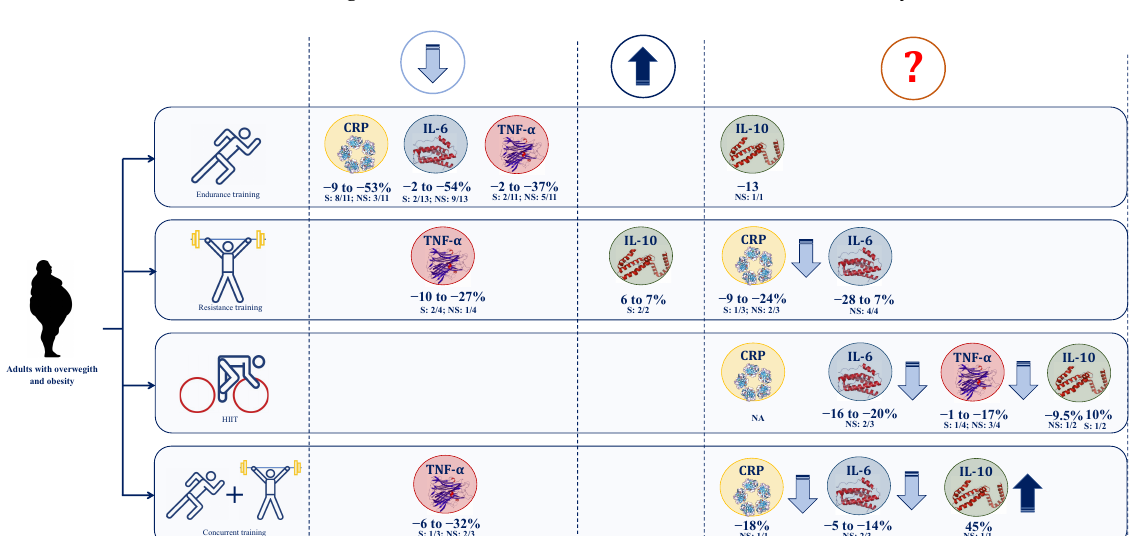
Figure 2. Summary of the results obtained from the systematic review. Note: ( concentrations levels. CRP, C-reactive protein; HIIT, High-intensity interval training; IL-6, interleukin-6; IL-10, interleukin- 10; NA, not analyzed; NS, studies reporting non-significant differences; S, studies reporting significant differences; TNF- α , tumor necrosis factor alpha.